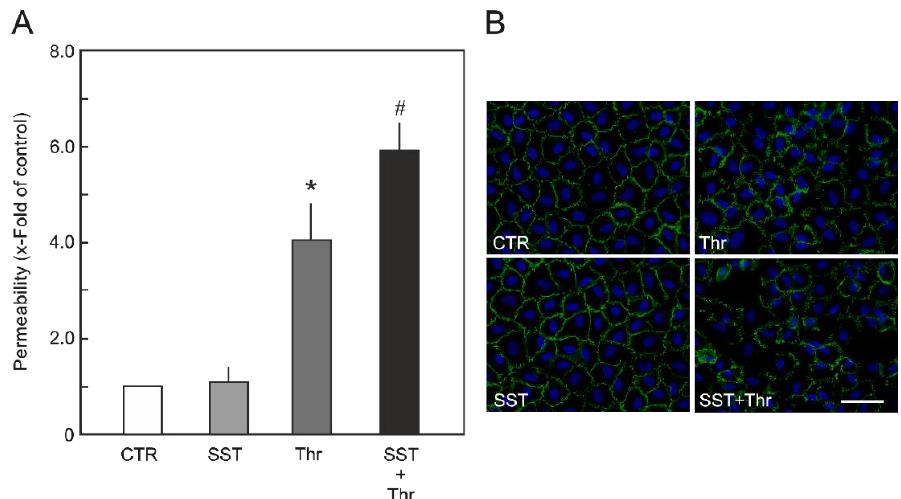
Figure 2. Effect of SST on endothelial barrier function . ( A ) HUVEC permeability: HUVEC mono- layers cultured on filter membranes were treated with SST14 (1 nM) or buffer (CTR) followed by treatment with thrombin (Thr; 0.5 U /mL). Flux of albumin across HUVEC monolayers 10 min (maximum effect) after Thr treatment is presented. n = 5; p < 0.05; * vs. control, # vs. Thr alone. ( B ) HUVEC monolayers cultured on glass coverslips were treated with SST14 (1 nM) or buffer (CTR) followed by treatment with thrombin (Thr; 0.5 U /mL). Cells were fixed with ice-cold methanol and VE-cadherin was immuno-stained using a mouse anti-VE-cadherin (human) antibody. Scale bar: 50 µ